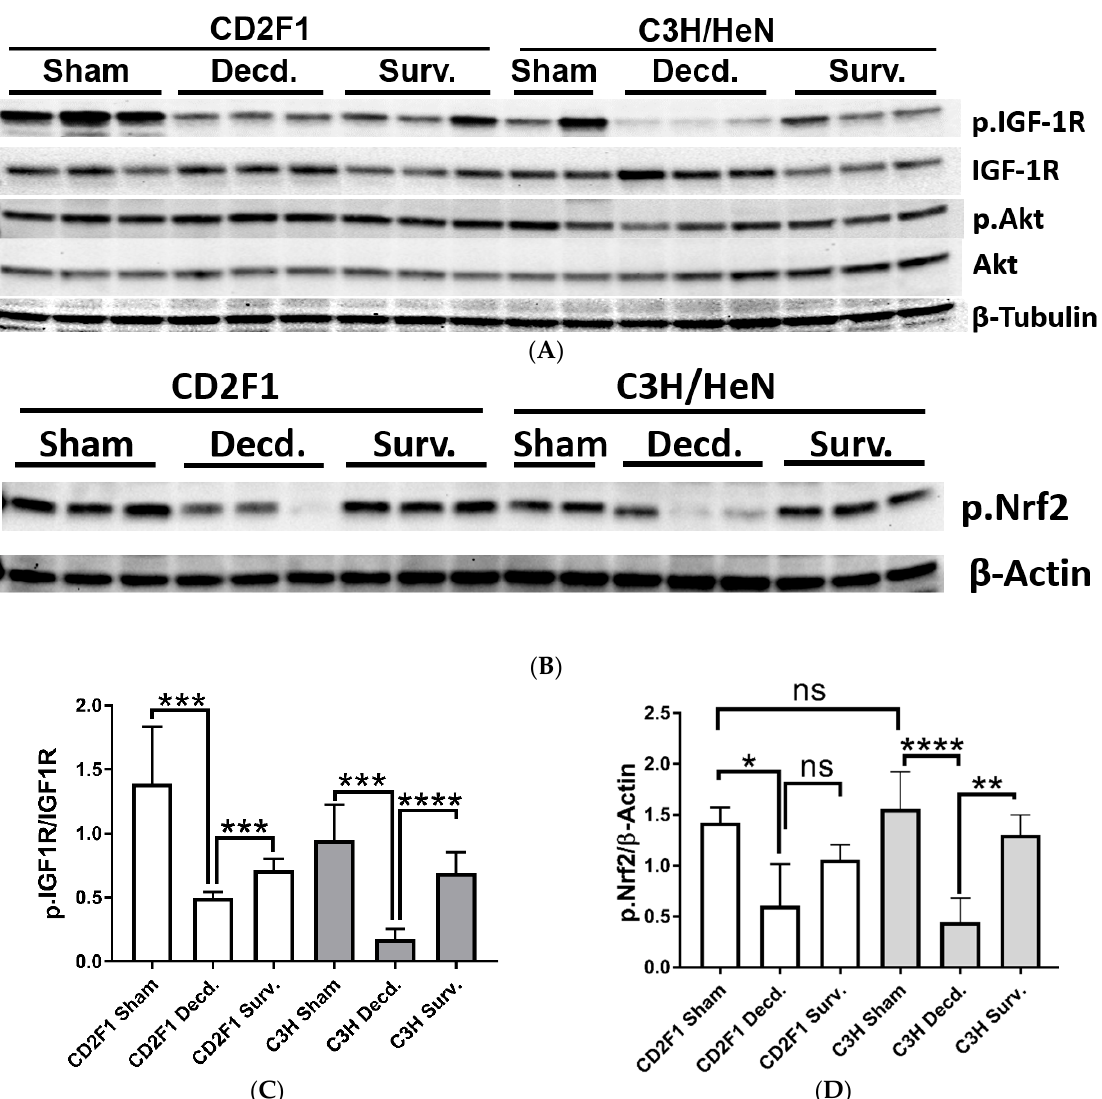
Figure 3. Western blot analysis of IGF-1R, Akt and Nrf2 activation in sham and LD 70/30 irradiated CD2F1 and C3H/HeN adult male mice. ( A , B ) Analysis of phosphorylated IGF-1 receptor (p.IGF1R, Tyr1135/1136), total IGF-1R, phosphorylated Akt (p.Akt, Ser473), total Akt, phosphorylated Nrf2 (p.Nrf2, Ser40 residue), β –Tubulin and β –Actin in heart protein extracts from sham, irradiated decedent (Decd.) and irradiated survivor (Surv.) mice. ( C , D ) Quantification of the IGF-1R and Nrf2 activation. The Y axis in graphs represents the ratios of the respective measured pixel intensities of Western blot bands. Total number of analyzed samples from both CD2F1 and C3H strains: sham— n = 6; decedent— n = 6; survivor n = 3. Data analyzed by Student’s t -test and are presented as mean ± SEM, * p < 0.05, ** p < 0.01, *** p < 0.001 and **** p < 0.0001, p > 0.05 considered as ‘not significant’ (ns).